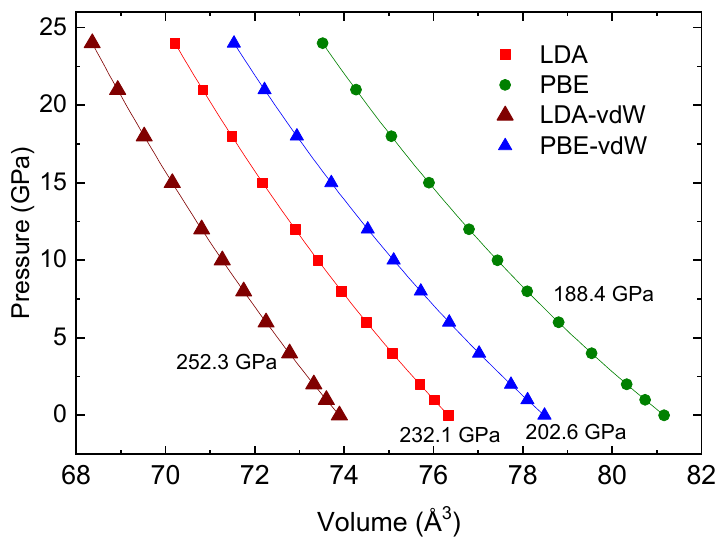
Figure 2. Calculated pressure-volume dependence for RhNiAs (solid dots) as obtained from LDA and PBE functionals, including or neglecting van der Waals (vdW) corrections. The curves show fits of the calculated points to a third-order Birch–Murnaghan equation of state. The resulting bulk moduli are given next to each curve.